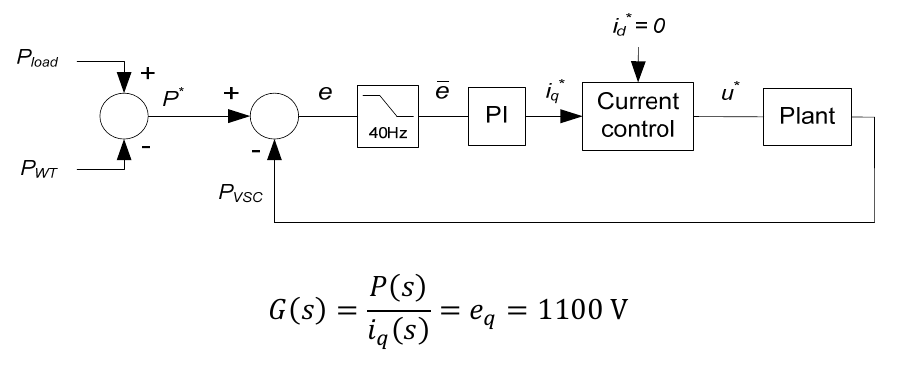
Figure 10. Block diagram of the active power